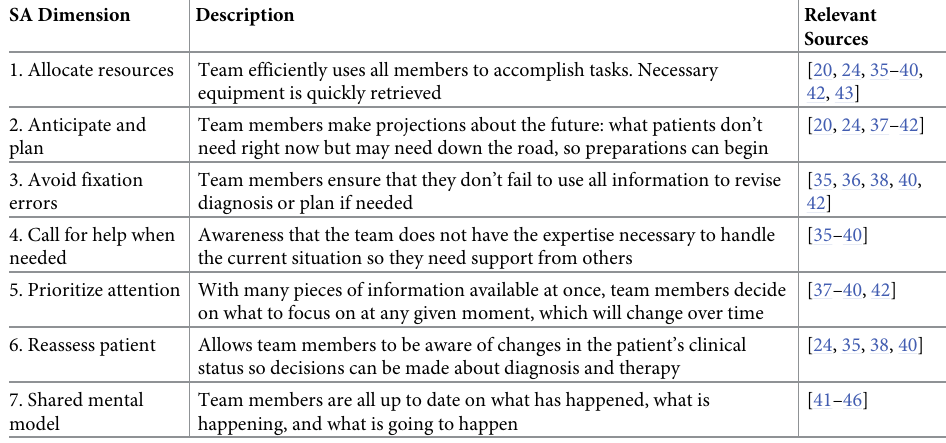
Table 1. Proposed seven-dimensional SA framework and sample sources. SA